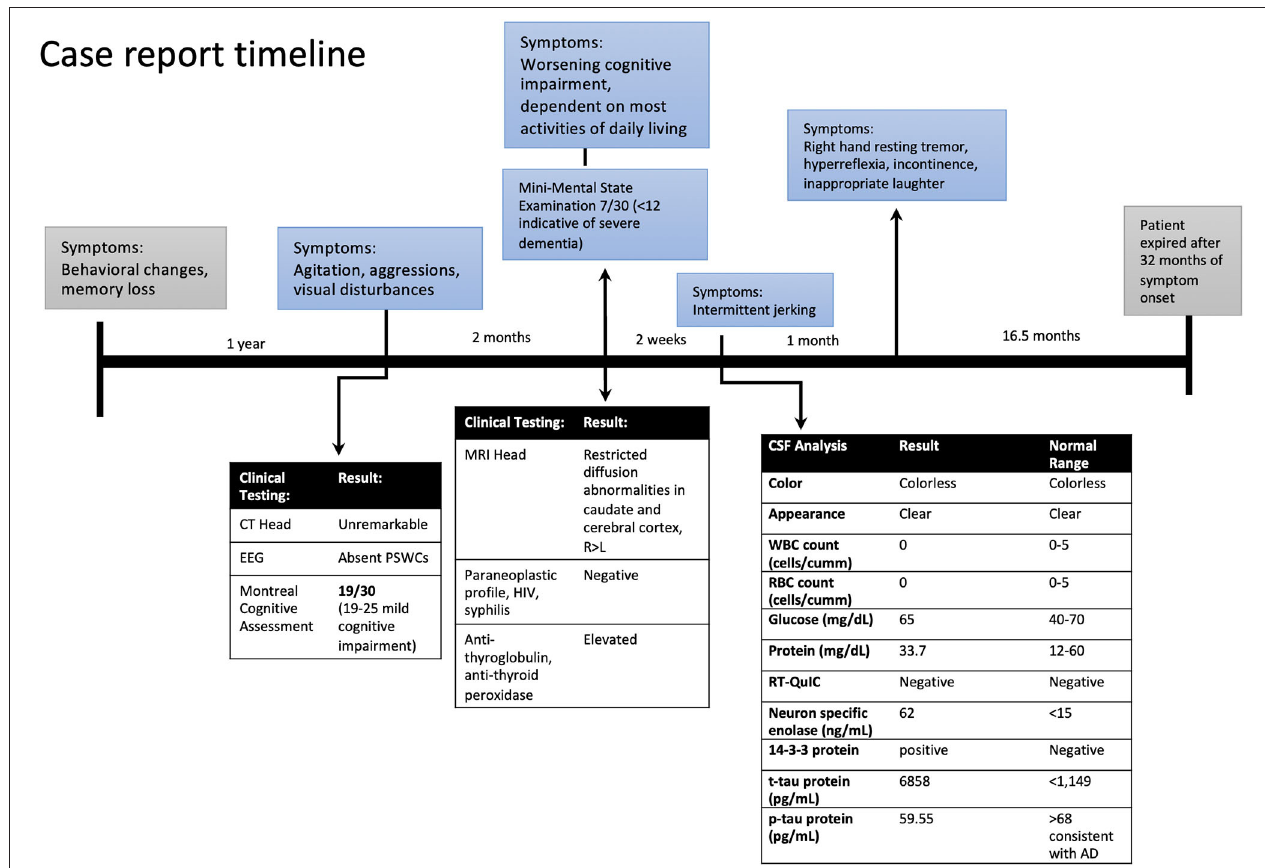
FIGURE 2 | Diffusion-weighted imaging (DWI) axial view, apparent diffusion coefficient (ADC) view, and regional volumetric studies. Asymmetric DWI increased signal intensity in the cortical ribbon of the parietal, frontal, and temporal lobes, hippocampi, caudate, and putamen. The signal hyperintensities are greater on the right. (A) Image shows increased signal intensity in the cingulate cortex (yellow arrow). (B) More superior image shows diffuse asymmetric involvement of parietal, frontal, and temporal lobes. There is notable involvement of the caudate head that is greater on the right (red arrow ). (C) ADC sequence illustrating caudate changes (red arrow ) consistent with the DWI hyperintensities. (D) Brain atrophy pattern (highlighted in red), mainly on the right frontal, temporal, and parietal lobes, consistent with areas of abnormal DWI in